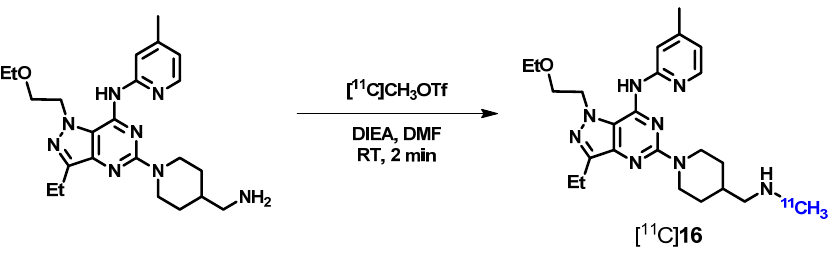
Scheme 6. Radiosynthesis of [ 11 C] 16 Scheme 6.